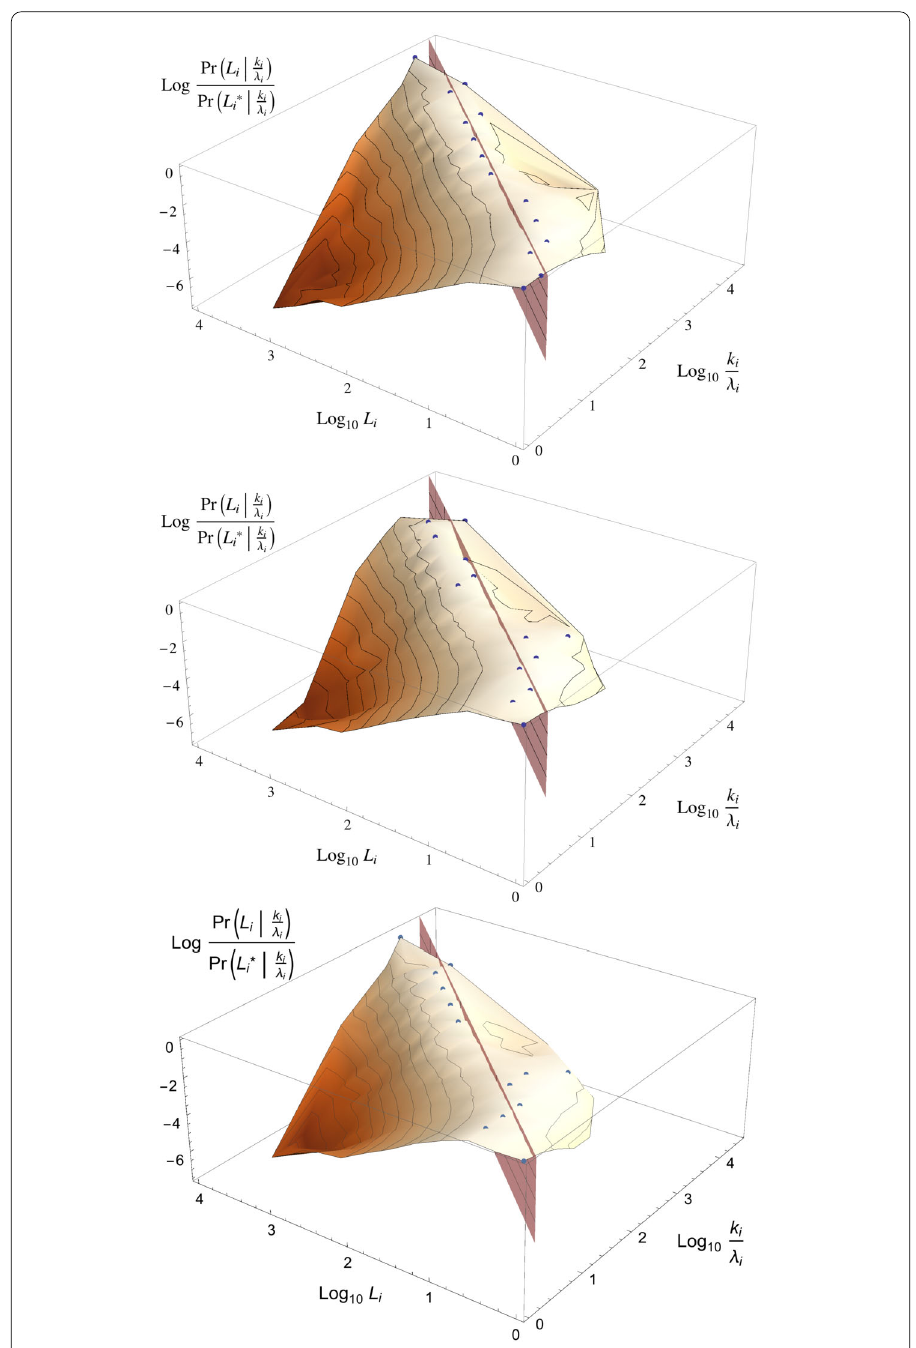
| k S ) with respect to log λ i for Figure 21 Behavior of log 10 [Pr( L i | k i / λ i )/Pr( L ∗ i / λ i )] (surface 10 L i and log 10 k i / i Finland when A is created with links where the traffic has a minimum of 3,4,5 transitions (top, middle, bottom plots). The data is logarithmically binned as follows: L i belongs to bin b (a non-negative integer) if L min ζ b < L i ≤ L min ζ b +1 with ζ > 1 (for this plot ζ = 2) and L min = min[ { L i } ] (smallest firm size in the data); k i / λ i is binned in the same way with ζ and ( k / λ ) min = min[ { ( k i / λ i ) } ]. Blue points represent the local maximum of S at each bin. The vertical plane P (linear “best fit”) is parametrized as ( k i / λ i , C L k i / λ i , z ) where z is a free (cid:2) ∗ parameter. C L is chosen to minimize – C L ( k / λ ) b ) 2 with the first three bins excluded because the b ( L b smallest firm size is 1. The large range within which the intersection of P and S runs parallel to the maxima of S strongly supports Eq. (18) of the main